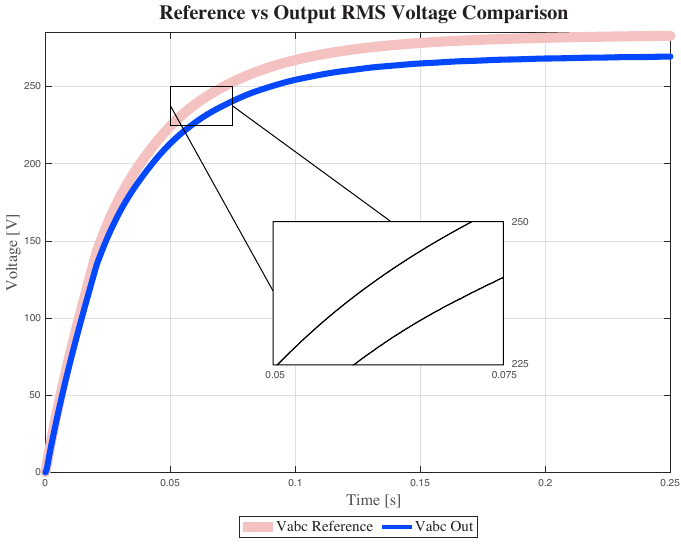
Figure 7. Comparing the RMS reference voltage output and the RMS output voltage inverter.